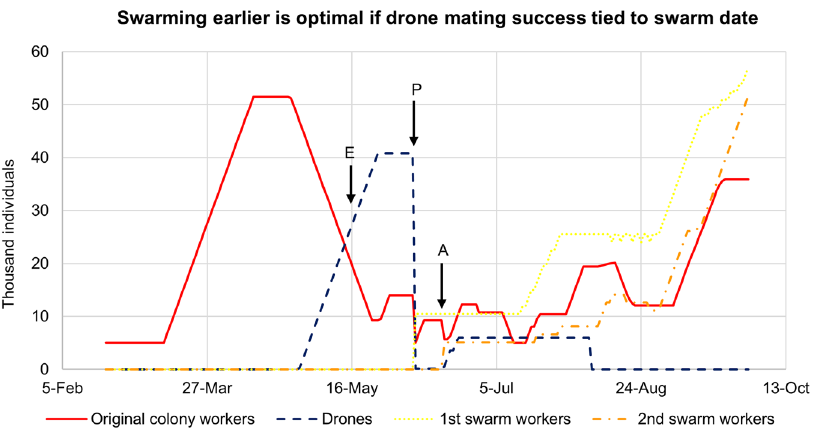
Figure 3. Swarming earlier is optimal if drone mating success is tied to swarm date. In model scenario 2, we assume that all colonies in the population adopt the same optimal timing of drone and swarm production, i.e. the focal colony optimizes the timing of drone and swarm production given that all colonies in the population produce queens and swarm at the same time as the focal colony. Under this set of assumptions, we find the optimal swarm date is in late May/early June and the optimal behavior is to maintain drones from April to late May, evict all drones just before swarming, and maintain a second wave of drones from June to August. The solid line shows the optimal number of workers in the parent colony on each day, the dashed line shows the optimal number of drones on each day, the dotted line shows the number of workers in the prime swarm and the dash-dot line shows the number of workers in the afterswarm. The letters P and A indicate when the prime swarm and afterswarm, respectively, are produced in the model. The letter E indicates the empirically measured swarm date 19 . The optimal swarm date predicted by model scenario 2 is much closer to the empirically observed date than that predicted by model scenario